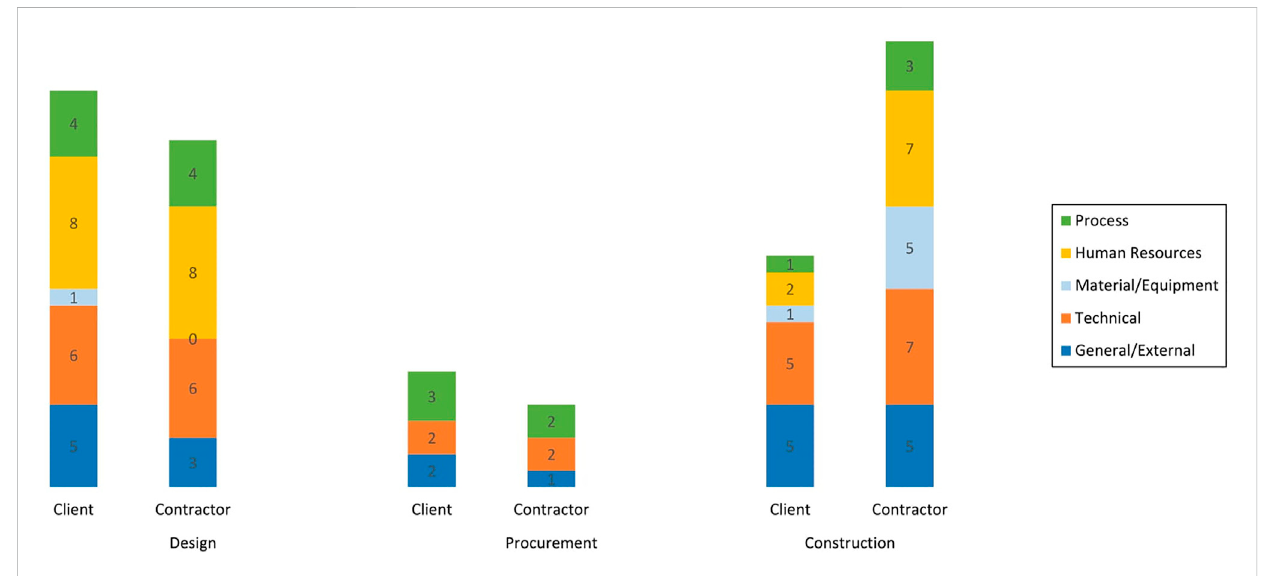
Distribution of rework factors in three stages of